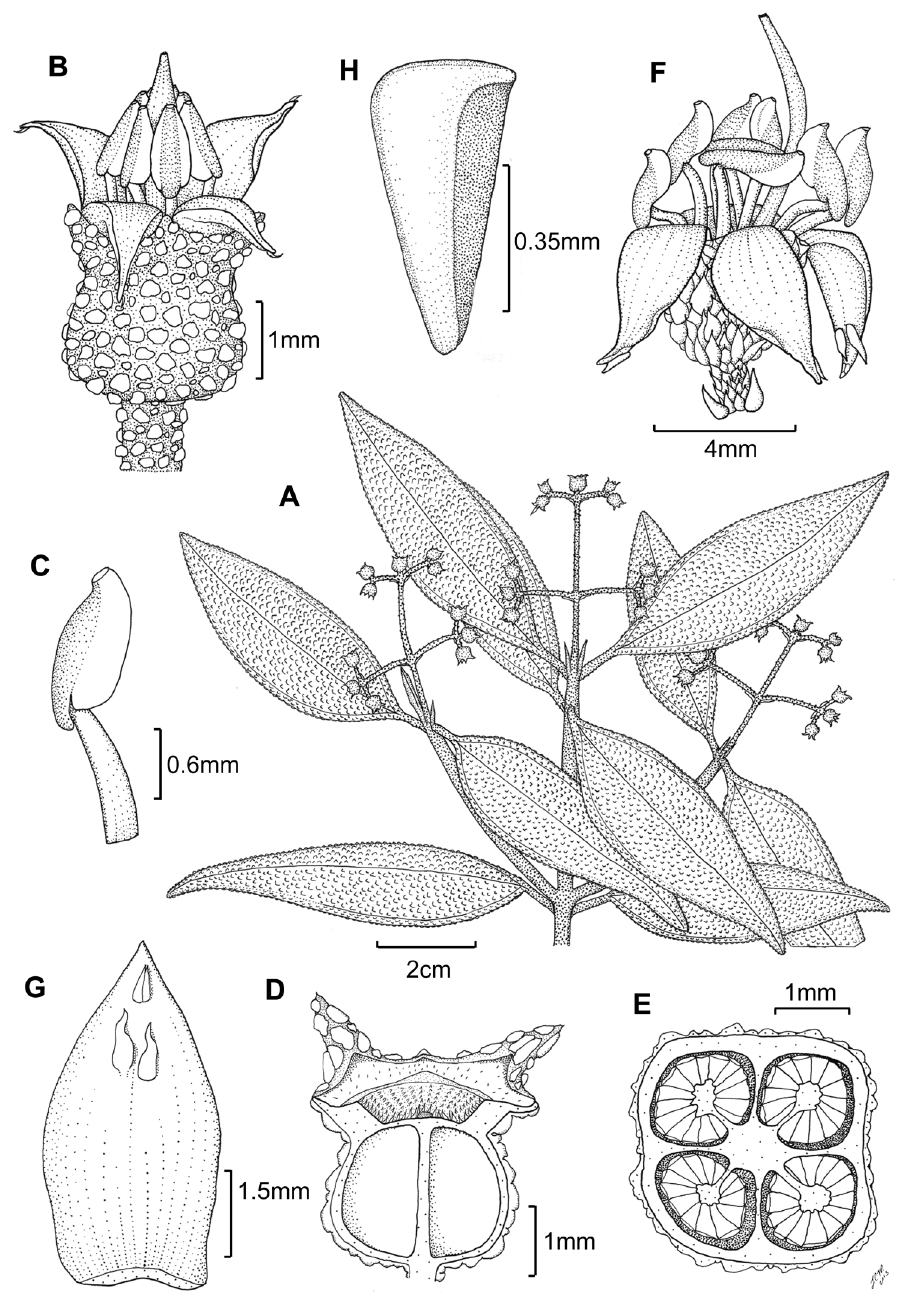
Figure 7. Illustration of M. granulata ( A–E ) and M. norlindii ( F–H ). A Habit of M. granulata from the type specimen ( Ekman 3789 ) B flower C stamen D fruit longitudinal section E fruit cross section (all from Acuña 13288 ) F flower of M. norlindii ( Pipoly 24478 ) G petal ( Pipoly 24478 ), and H seed ( Clemente NSC-5814